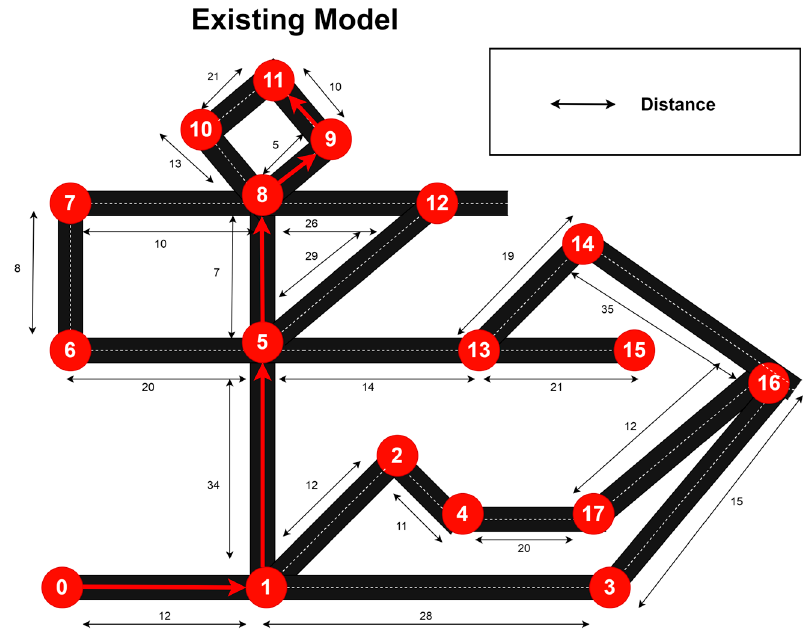
Figure 3. The shortest path derived from the existing model.